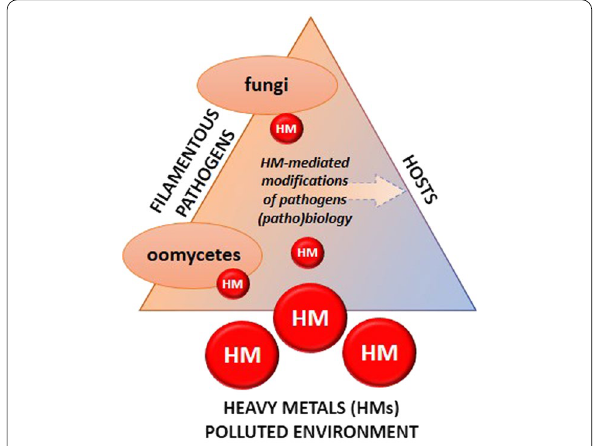
Fig. 2 A model linking HMs stress and modification of the microorganisms pathogenicity. Both fungal and fungal‑like pathogens inhabit comparable aquatic and soil habitats. Thus, environment pollution, and especially soil or water contamination with HMs can significantly affect the pathogens capability to infect host